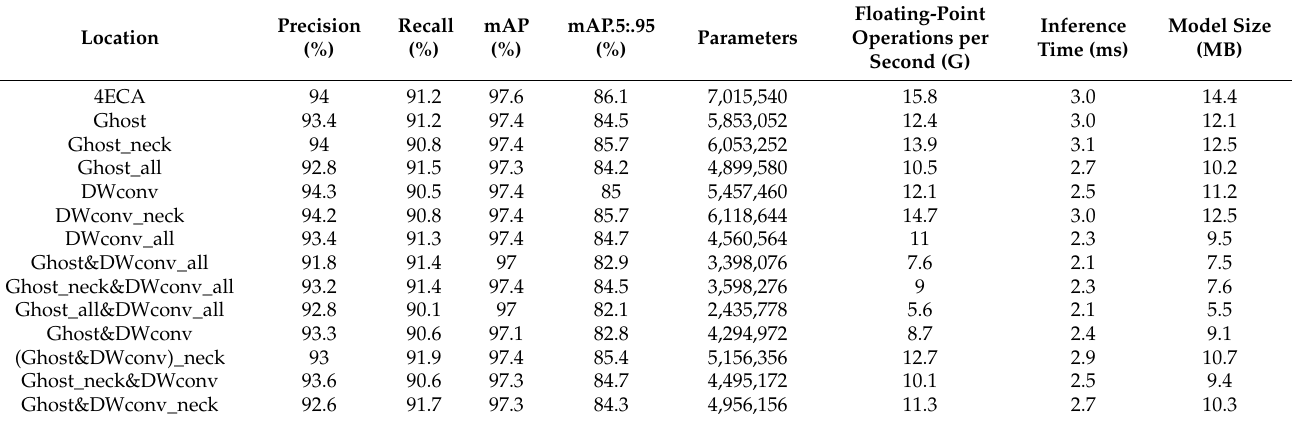
Table 5. Results of the lightweight experiment. “_neck” means that the location of the introduction is the neck network, “_all” means that the location of the introduction is the full network, and the unmarked means that the location of the introduction is the backbone